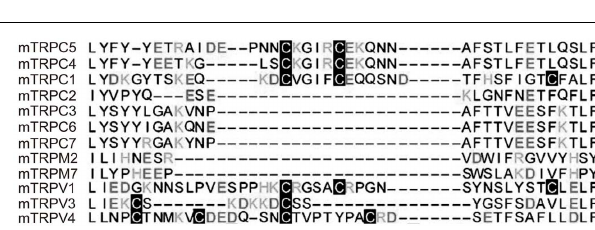
FIGURE 2 | Conserved cysteine residues on the N-terminal side of putative pore-forming regions inTRPs. Alignment of variousTRPs with the Cys553/Cys558-containingTRPC5